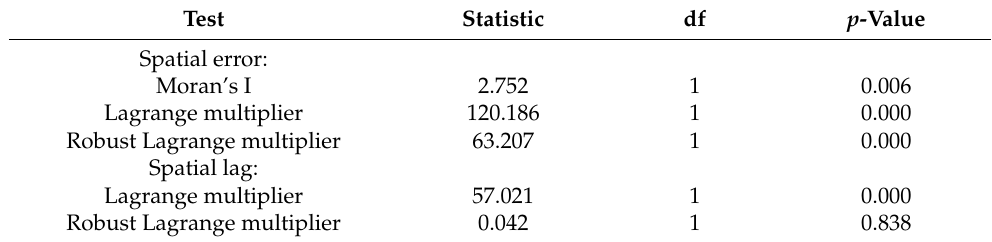
Table 8. Spatial effect